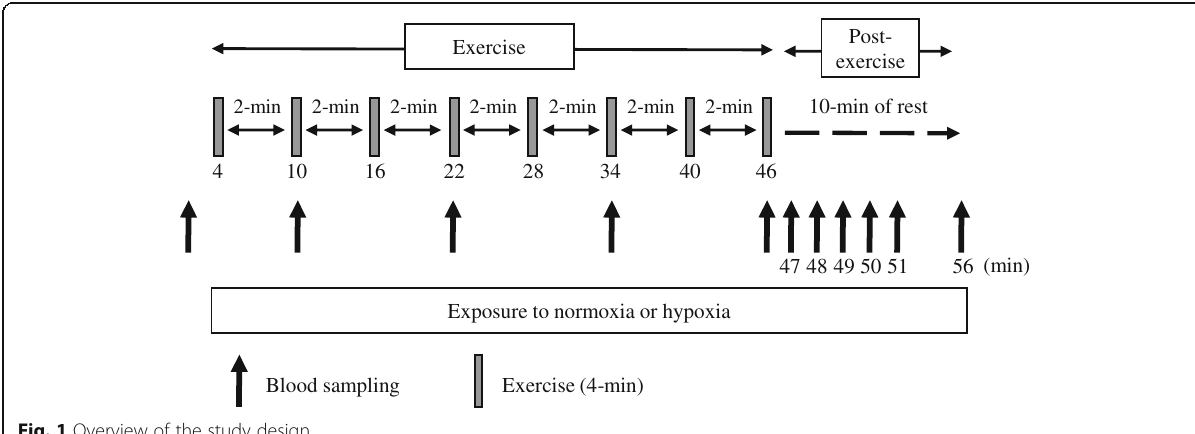
Fig. 1 Overview of the study